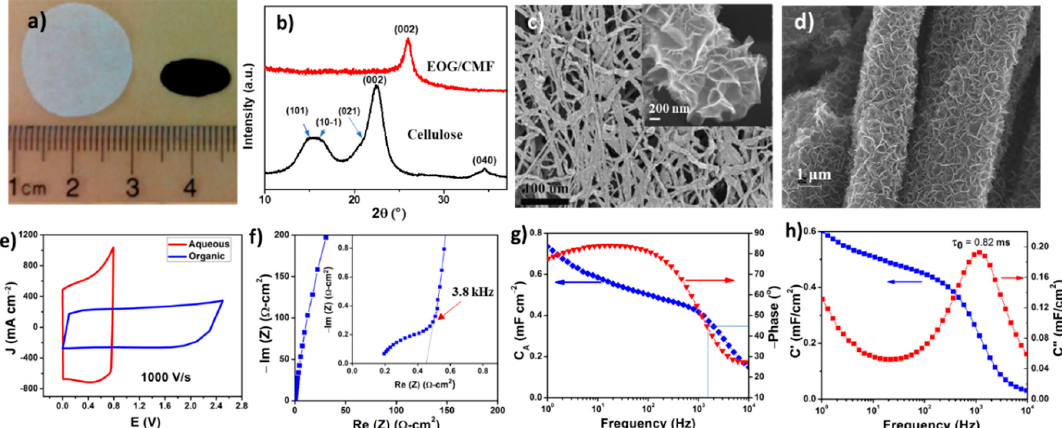
Figure 4. ( a ) Photo showing the cotton round (cellulose sheet, the white one) and the VG/CMF sheet (the black one). ( b ) XRD patterns of the cellulose and the VG/CMF sheets. ( c , d ) SEM images of VG/CMF at different magnifications. Electrochemical performances of VG/CMF electrode: ( e ) CV curves at 1000 V s − 1 rate in aqueous and organic electrolyte cells. ( f ) Nyquist impedance spectrum with the inset showing the zoom-in high frequency range, ( g ) RC model-derived electrode’s areal capacitance vs. frequency plot and its Bode diagram, and ( h ) real and imaginary components of the complex electrode capacitances in an organic cell. Reproduced with permission from Ref. [6] for ( a – c ), Copyright 2016, and Ref. [9] for ( e – h ), Copyright 2019, Elsevier.